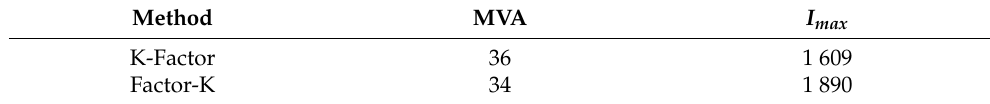
Table 15. Derating factor